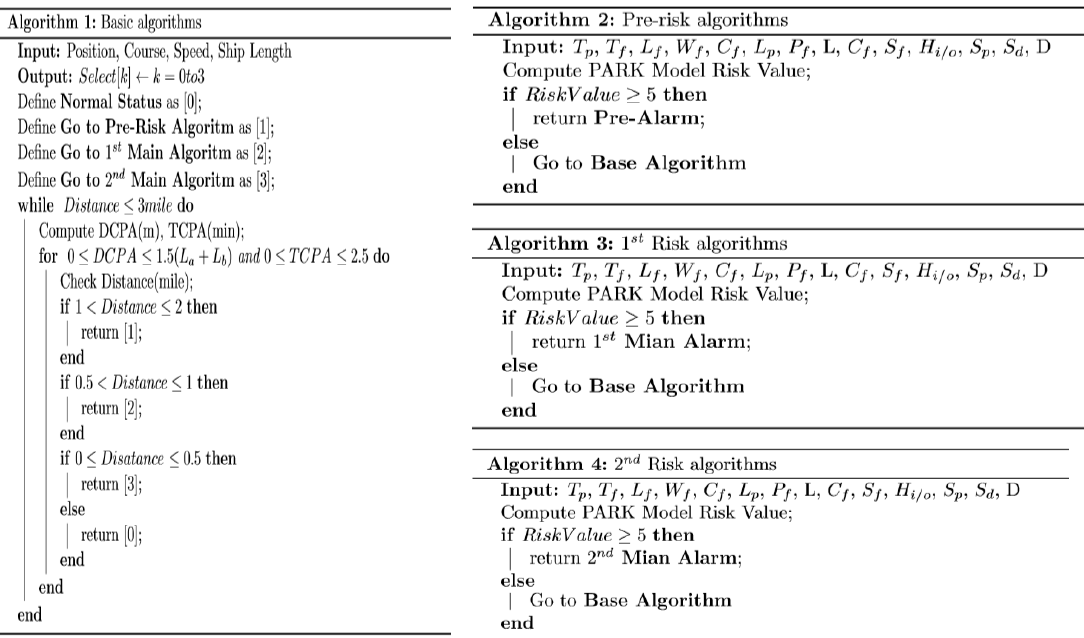
Figure A1. Pseudo-code for collision prevention algorithm for small fishing vessels.